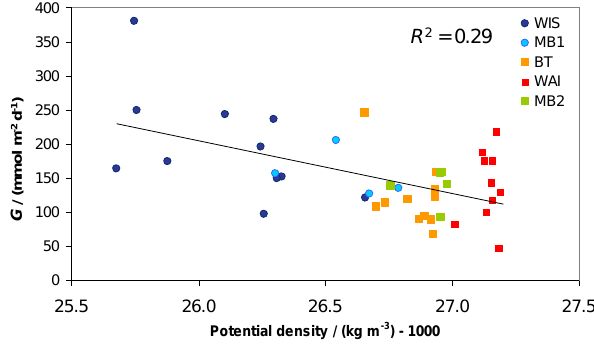
Fig. 8. Linear correlation ( R 2 = 0.29) between potential density and mixed-layer average G .